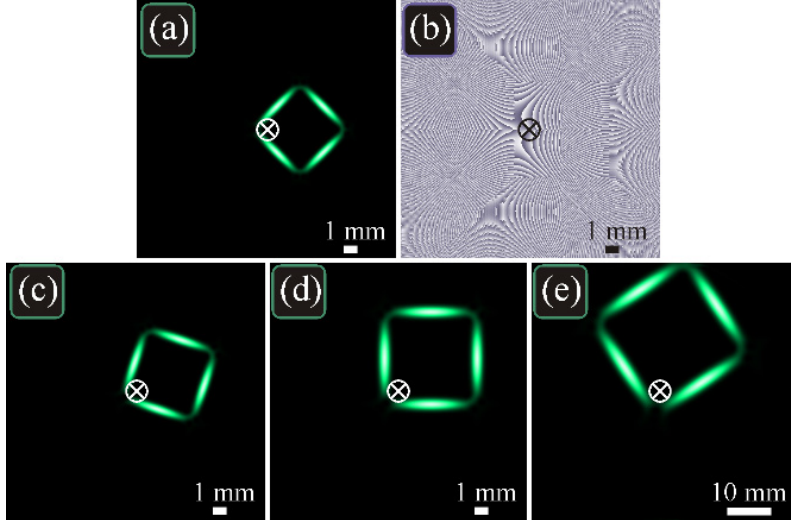
Figure 6. Intensity ( a , c – e ) and phase ( b ) distributions of the off-axis square propagation-invariant beam in the initial plane ( a , b ), in the near field z = z 0 /2 ( c ), at the Rayleigh distance z = z 0 ( d ), and in the far field z = 5 z 0 ( e ) for the following parameters: wavelength λ = 532 nm, waist radii of all four elliptic Gaussian beams σ x = 2152 μ m and σ y = 358 μ m ( w 0 = 500 μ m), coordinates of the beam centers ( x 0 p , y 0 p ) = ( r 0 + r 0 cos φ p , r 0 sin φ p ) ( r 0 = 2.5 mm, φ p = π /4 + π p /2, p = 0, 1, 2, 3), tilt angles of the major axes of the ellipses to the x -axis α p = φ p + π /2, computation domain | x |, | y | ≤ R with R = 10 mm ( a – d ) and R = 30 mm ( e ). The cross in the center shows the optical axis, around which the diffraction pattern rotates on propagation. The initial field ( a , b ) was obtained by Equation (22), whereas distributions in the other planes ( c-e ) were obtained by the numerical Fresnel transform.